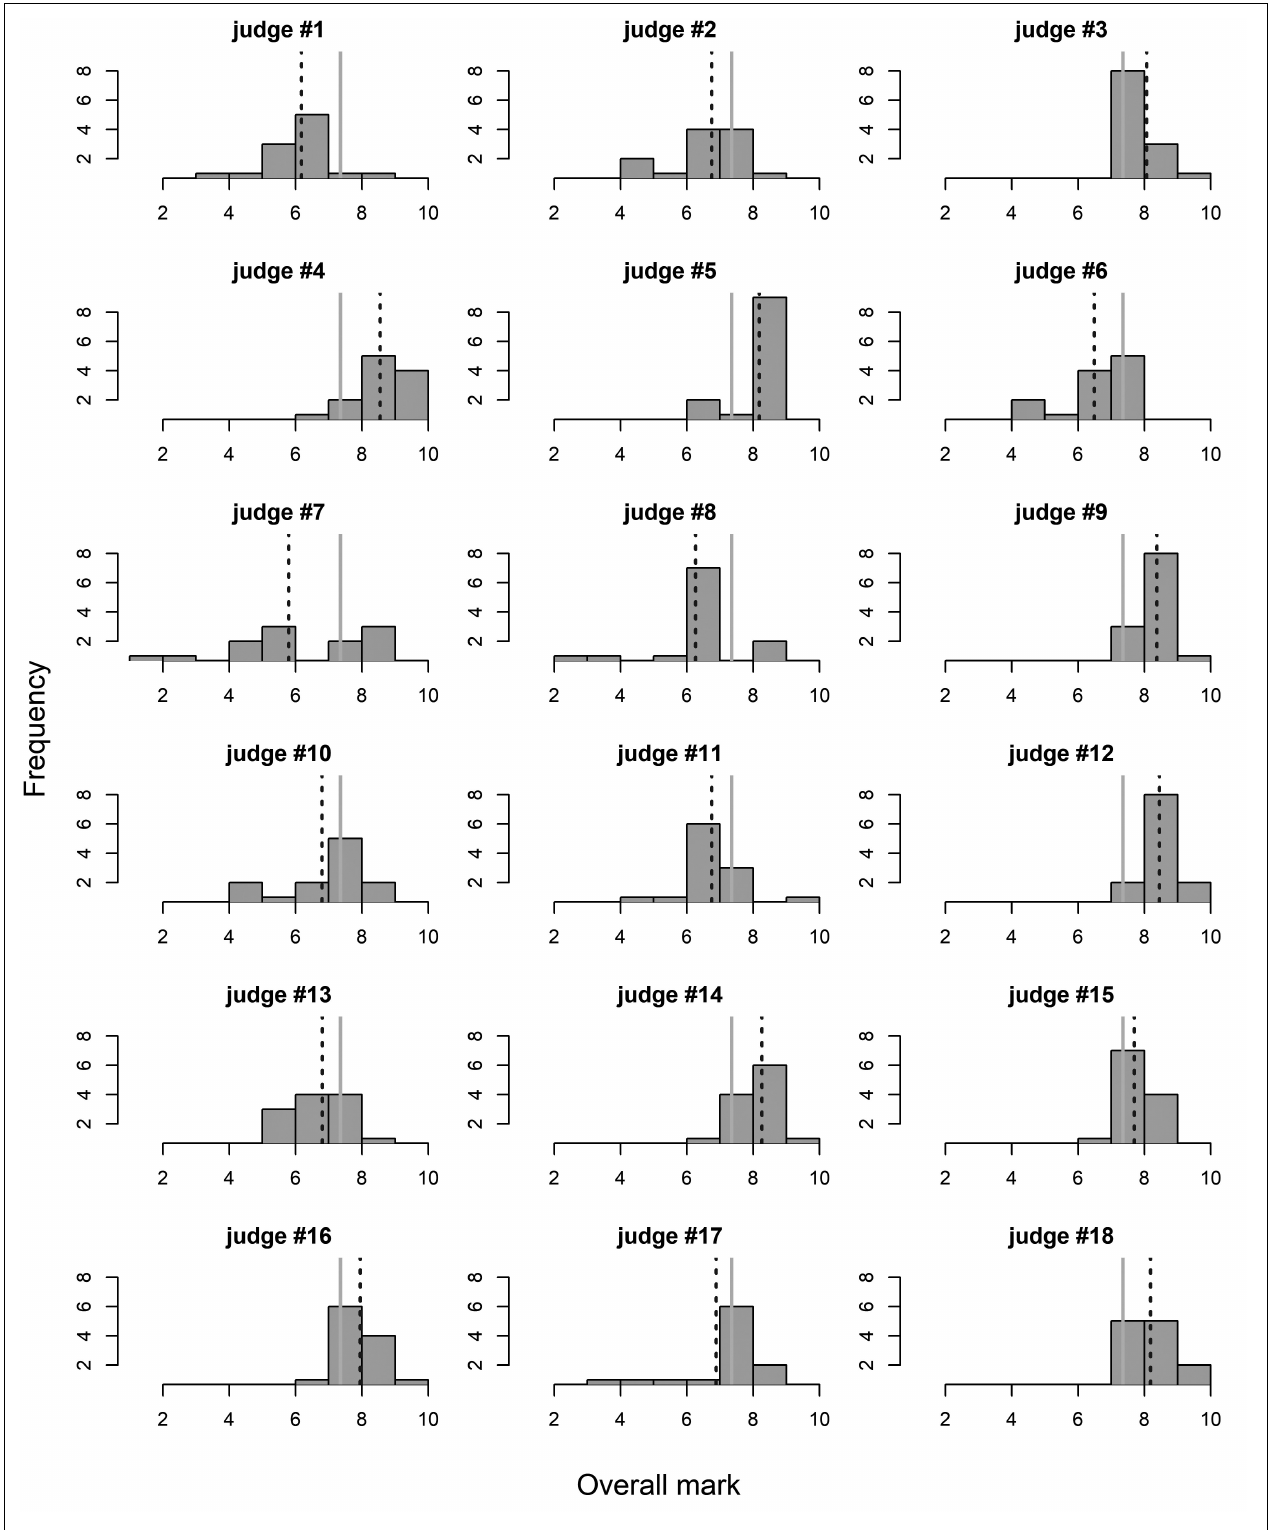
FIGURE 1 | Histograms of the overall marks for competitors ( n = 12) by individual judges. Key: solid vertical lines denote grand average (all judges combined), while dotted lines denote averages for individual junges.